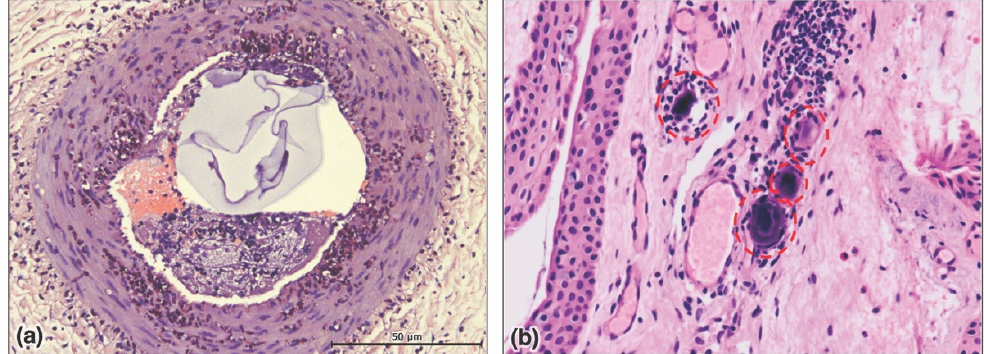
Figure 13. Histology of filler-induced vascular occlusion. ( a ) Hyaluronic acid (HA) dermal filler evident as an intraluminal plug within the central auricular artery in the rabbit ear model on post-injection day 1; from Zhuang et al. [166], with permission. ( b ) Histological section of bulbar conjunctiva of patient with filler-induced vision loss, showing occlusion of the distal microcirculation (capillaries and arterioles) with filler particles (red circles); from Hsiao et al. [176], with permission. These distal emboli can fully or partially obstruct any component of the arterial tree, including small arterial branches (~400–1000 µ m), subcutaneous arterioles (~100–400 µ